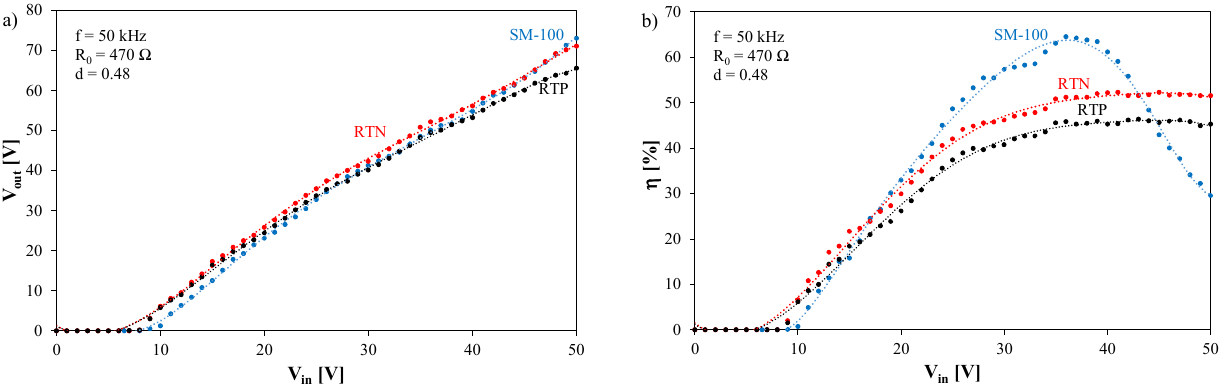
Figure 8. Measured dependences of the output voltage ( a ) and energy efficiency ( b ) of the tested DC-DC converter on its input voltage at f = 50 kHz and R 0 = 470 Ω .